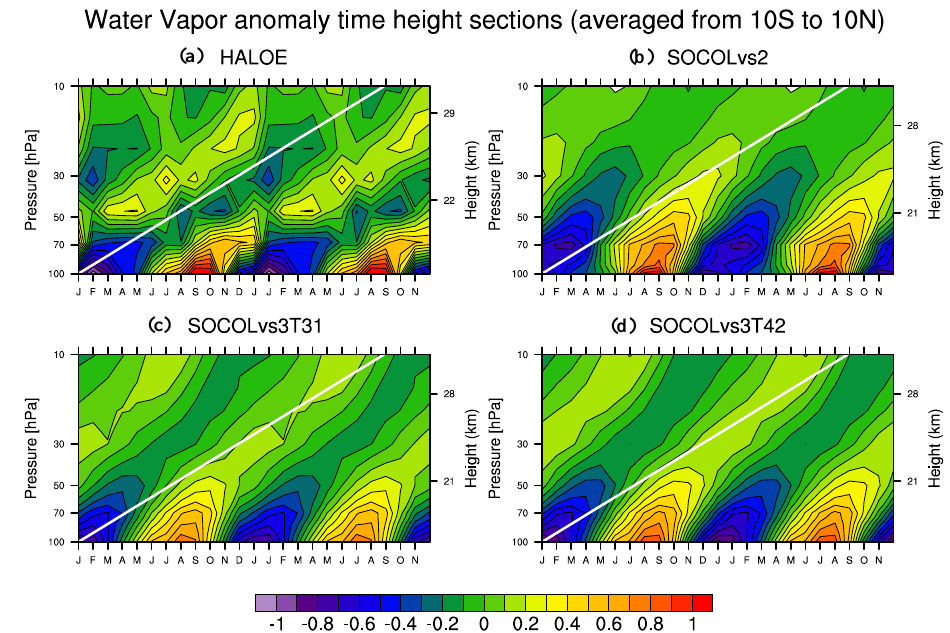
Fig. 8. Averaged (1992–2001) time–height sections of water vapor mixing ratio shown as the deviation from the mean profile, averaged between 10 ◦ N and 10 ◦ S for (a) HALOE, (b) SOCOLvs2, (c) SOCOLvs3 T31, and (d) SOCOLvs3 T42. Two consecutive (identical) cycles are shown. The white line indicates the phase speed of the HALOE tape recorder signal.